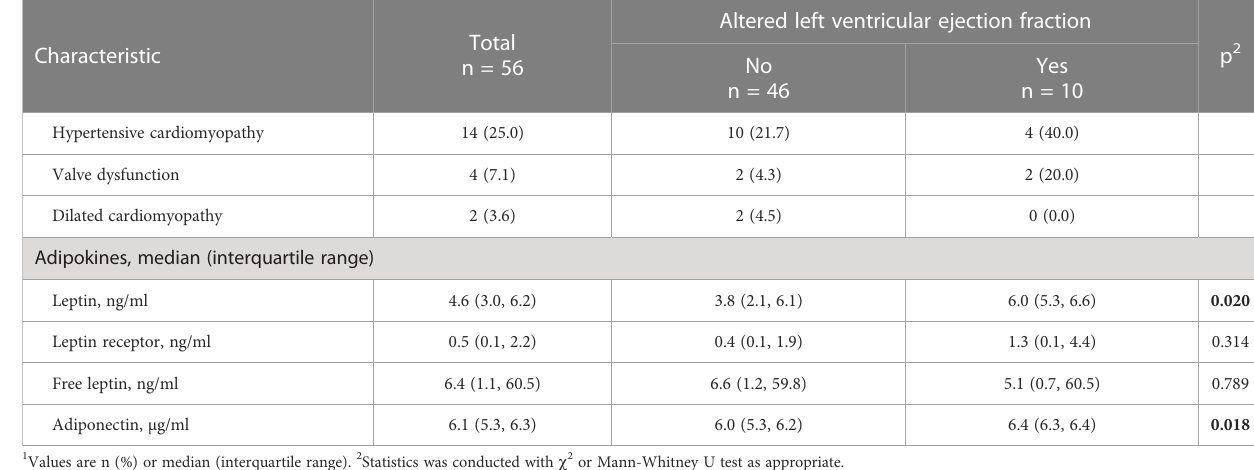
cytokine levels and delta-LVEF values. As shown, leptin (r=0.259, p=0.058) and free leptin levels (r=0.303, p=0.025) were positively